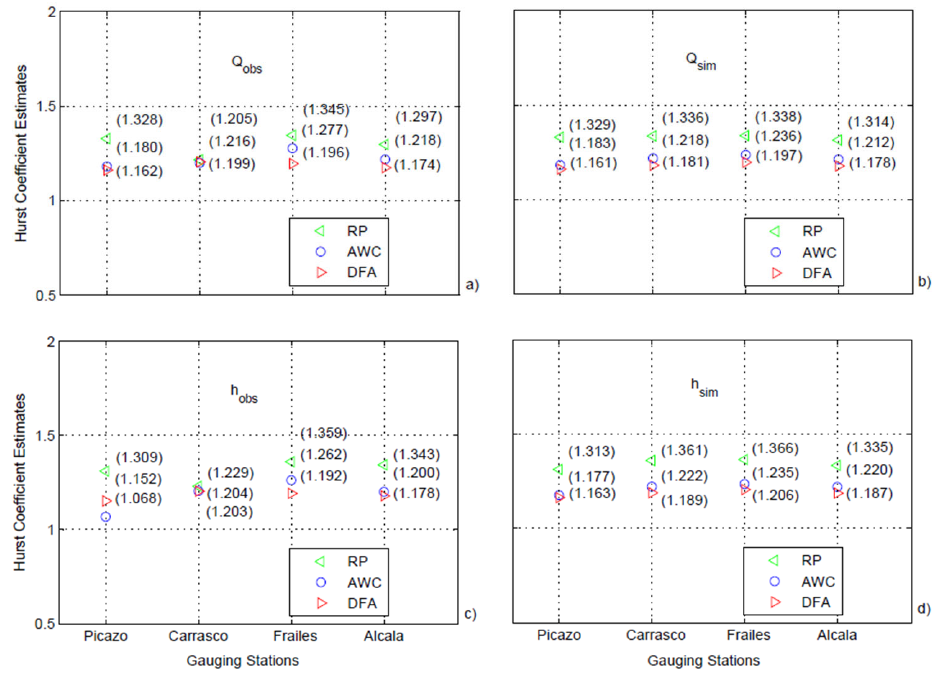
Figure 8. Hurst coefficient estimates of the observed and simulated values of Q ( a , b ) and h ( c , d ). The three different estimation methods used are: regression on periodogram (RP), averaged wavelet coefficients (AWC), and detrended fluctuation analysis (DFA).